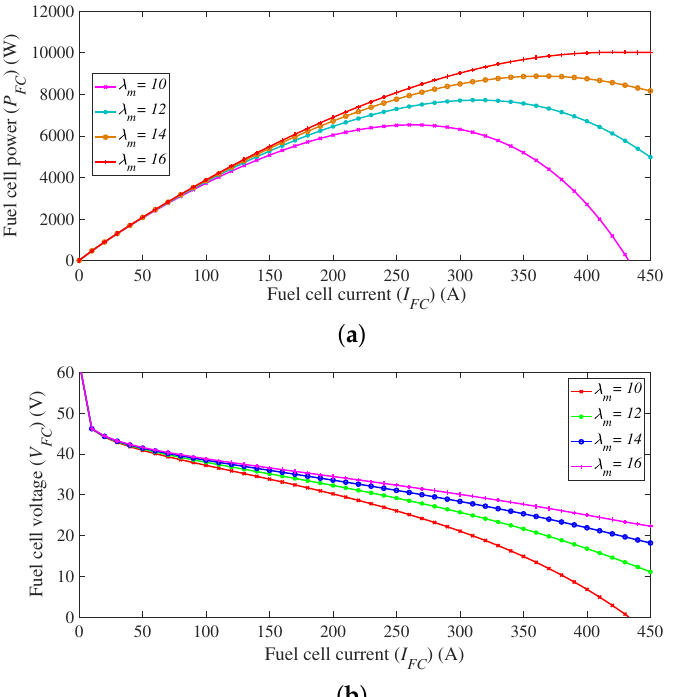
Figure 5. Modeled PEMFC curves at water content variations with constant temperature value T = 343 K; ( a ) P FC - I FC ; ( b ) V FC - I FC